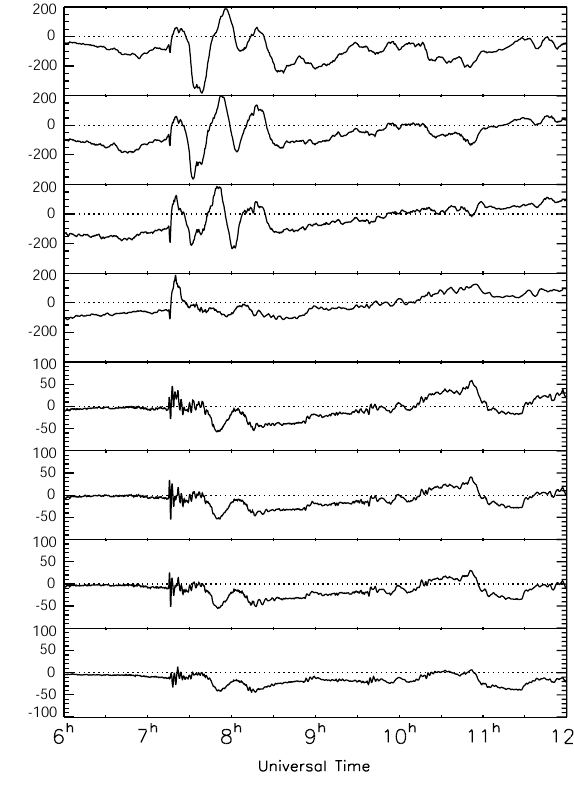
Fig. 5. Stack plot of H component ground magnetometer data from selected stations in the IMAGE network. The dotted horizontal lines represent